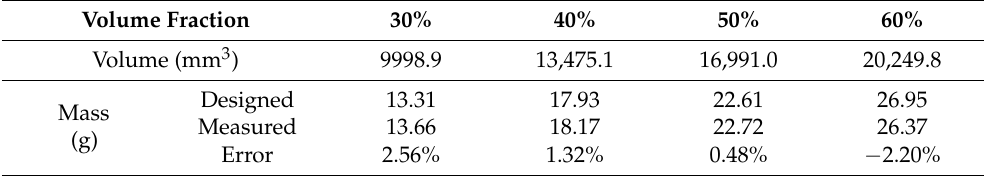
Table 5. Comparison for the mass of CLY-G type TPMSs with different volume fractions.